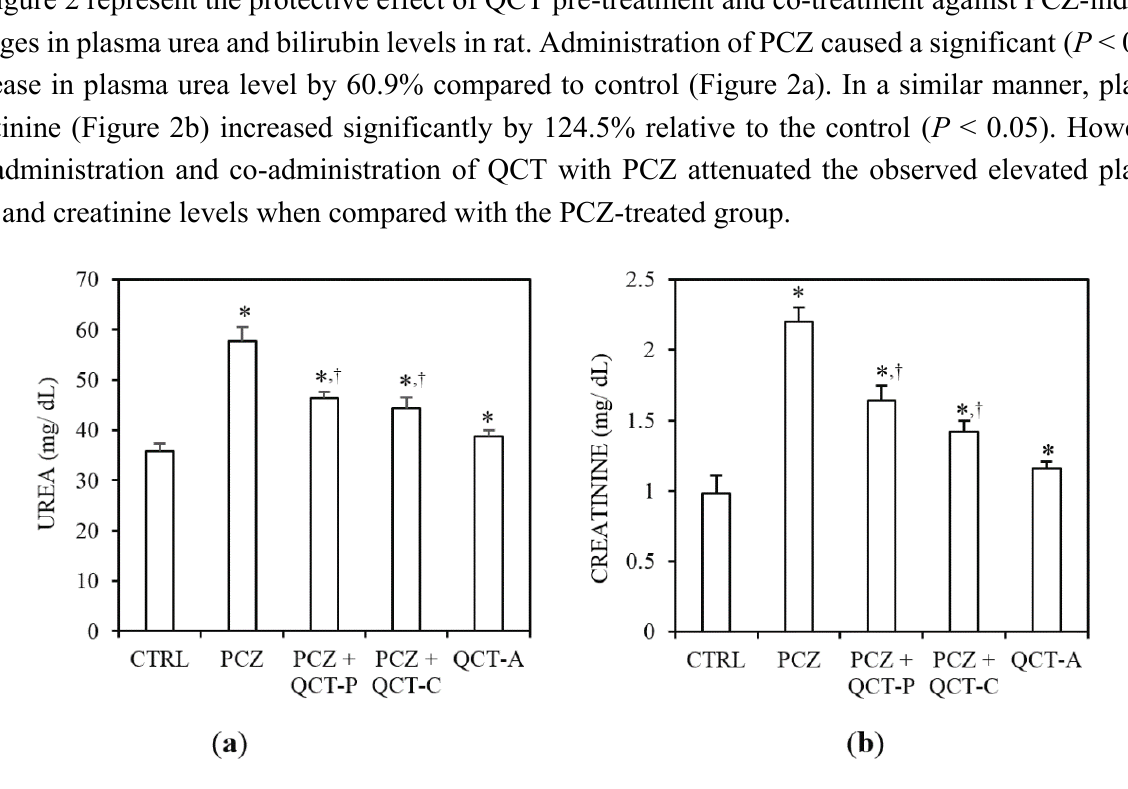
Figure 2. Protective effect of QCT pre-treatment and co-treatment against PCZ-induced changes in biomarkers of nephrotoxicity in rats. Data represent the means ± SD for five rats in each group; * significantly different from the CTRL; † significantly different from PCZ ( P <